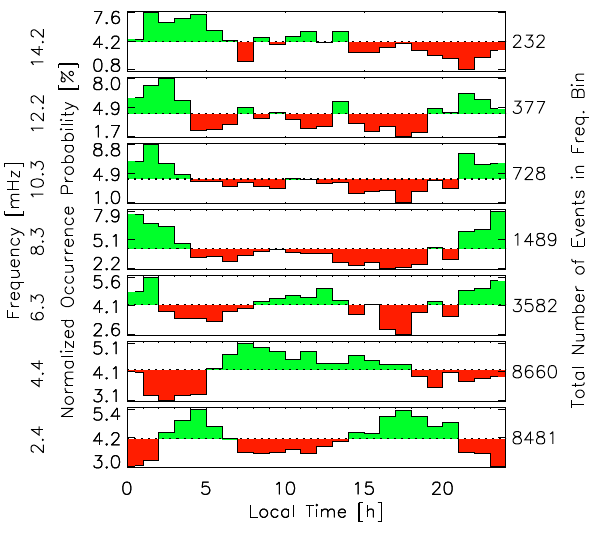
Fig. 7. Distributions of events of different frequency against local time normalized by the distribution of all events in local time. The percentage of occurrence of the events of each frequency bin is de- picted as well as the total number of events (numbers at the right edge of the figure) to which this percentage corresponds. Red and green bars show the differences to the mean percentage of 100 / 24 indicated by the dotted lines. Local time binning used: one hour.